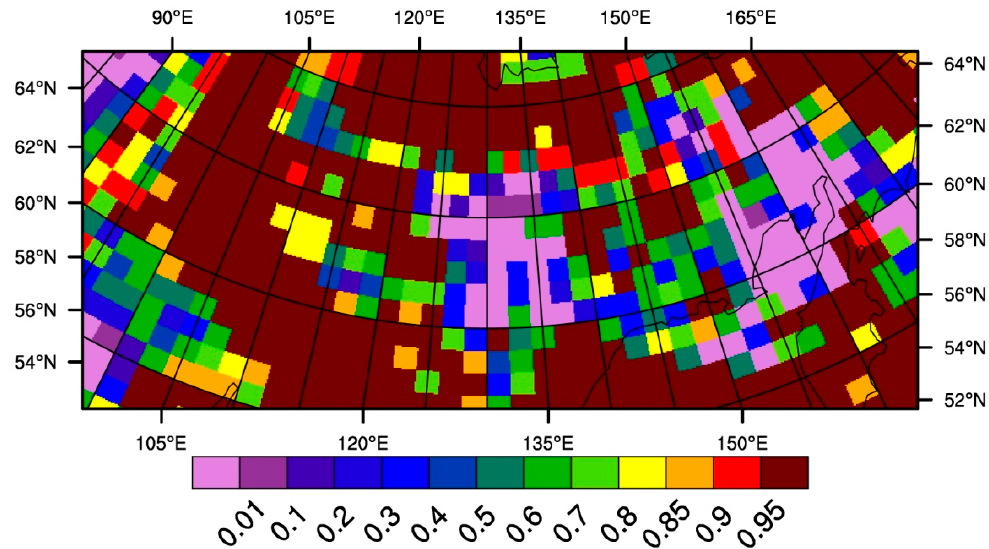
Figure 2. SRB cloud fraction used in the SRB dataset at 0600 UTC on 19 August 2002.